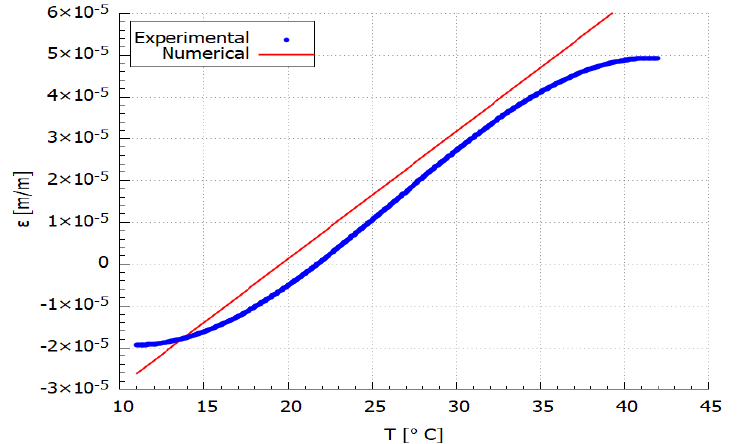
Figure 7. Comparison curves determined experimentally and